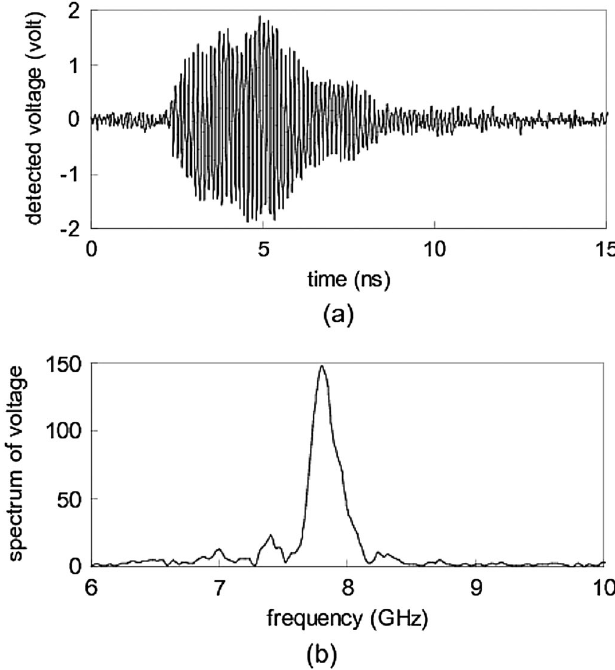
FIG. 11. Extracted rf signal measured on the Tektronix Oscilloscope during a beam test. Voltage signal excited by a 66 nC single bunch (a) and its spectrum (b).